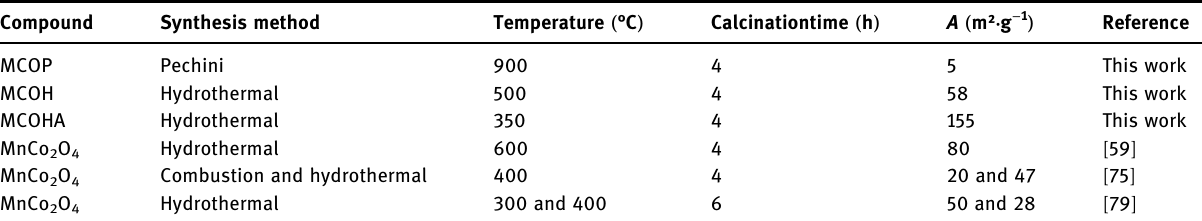
Table 2: BET surface area comparison between MCO synthetized in this work against the reported literature values